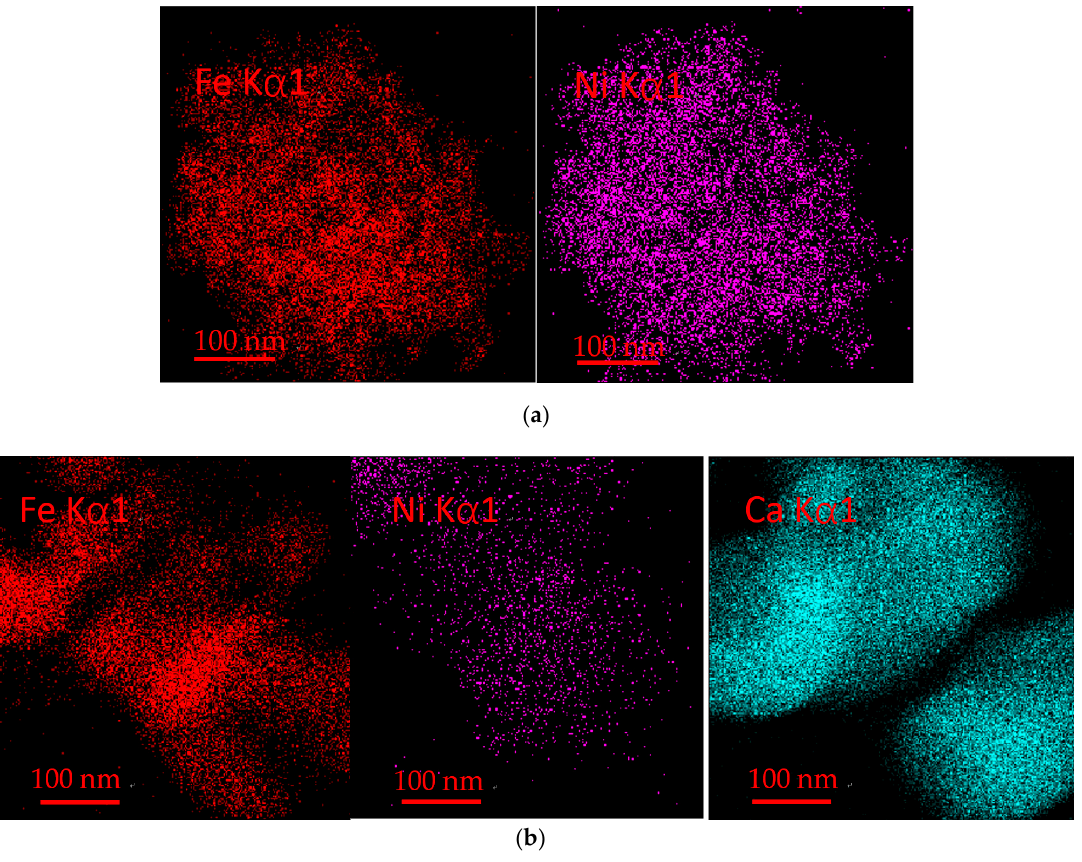
Figure 13. ( a ) EDS of fresh OC. ( b ) EDS of OC after 20 cycles.